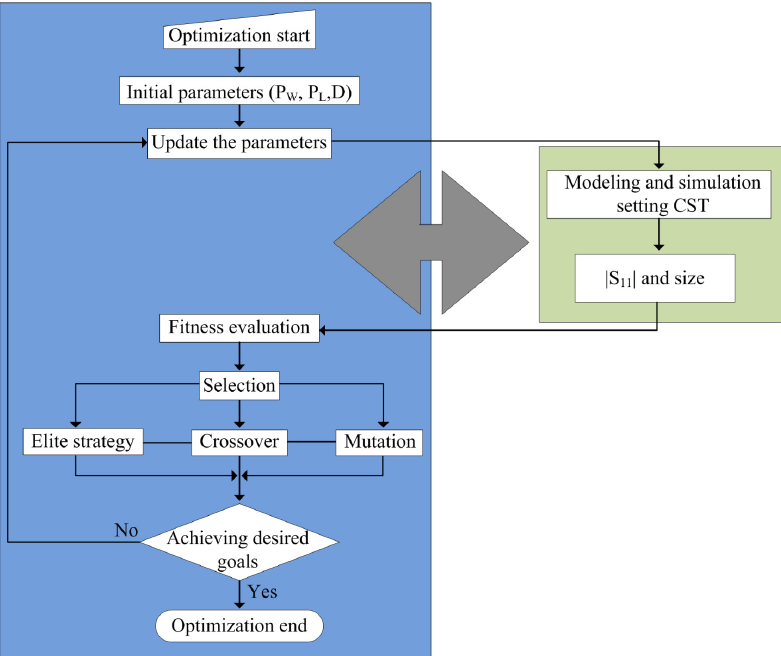
Figure 5. Flow chart explaining the optimization algorithm utilized for the proposed antenna.